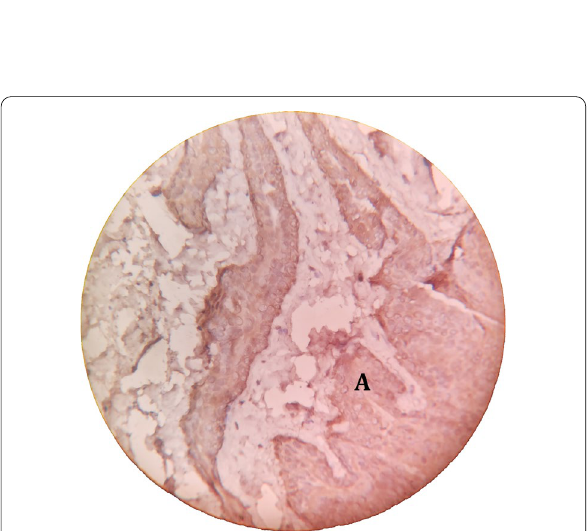
Fig. 16 IHC 20 image; showing EMA positivity in epithelial cell × lining of cyst wall as